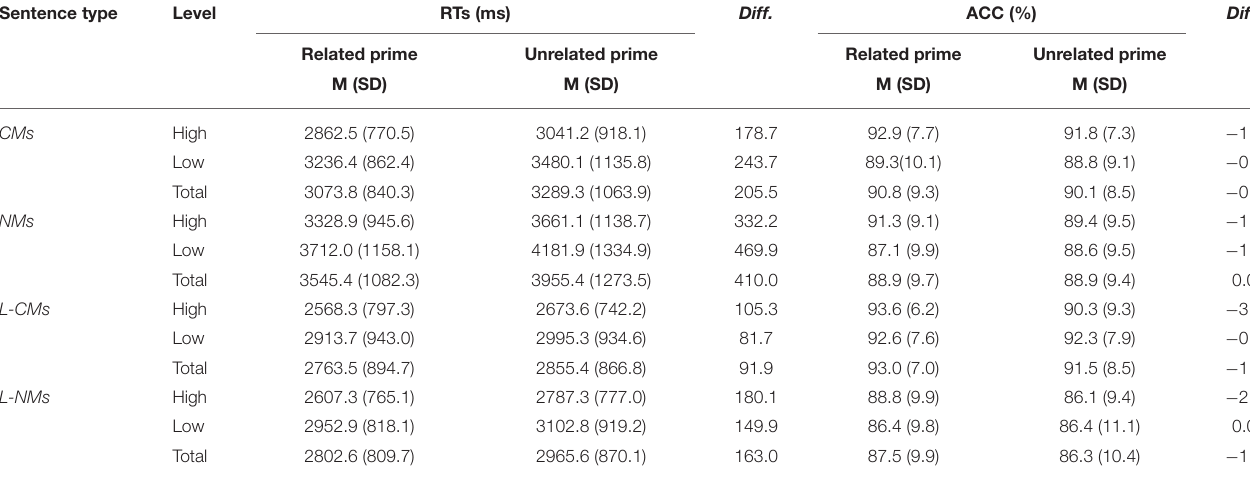
TABLE 4 | Mean (SD) reaction time (RTs) of target sentences and accuracy (ACC).